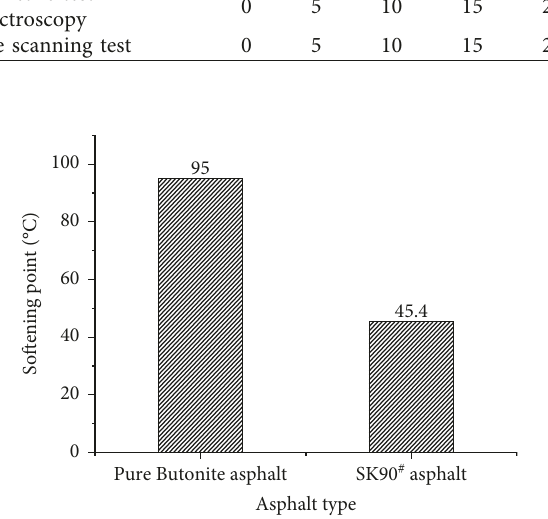
Figure 1: Pure Buton gilsonite and SK90 # asphalt softening point